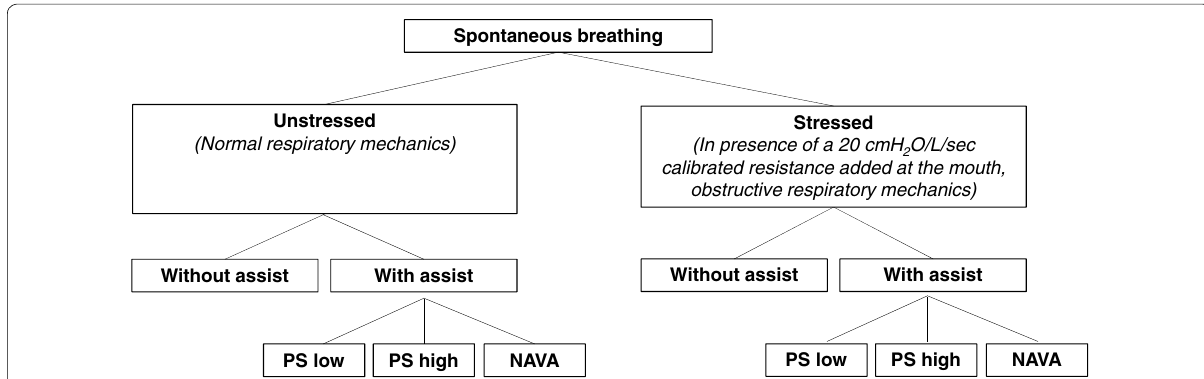
Fig. 1 Breathing conditions recorded in a randomized order. PS pressure support ventilation, NAVA neurally adjusted ventilatory